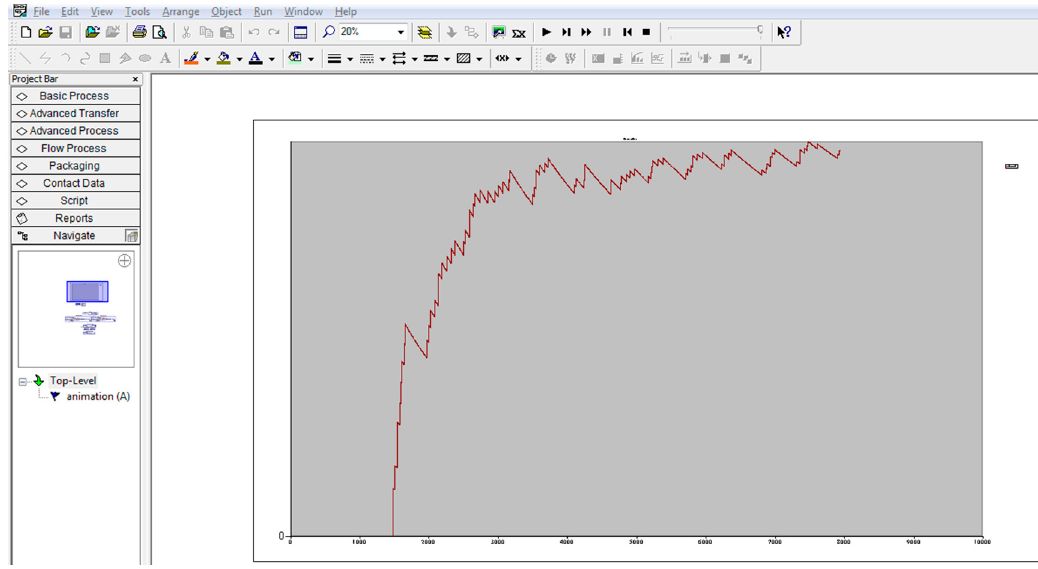
Figure 16. Plot of daily average entity output to identify the warm-up period.